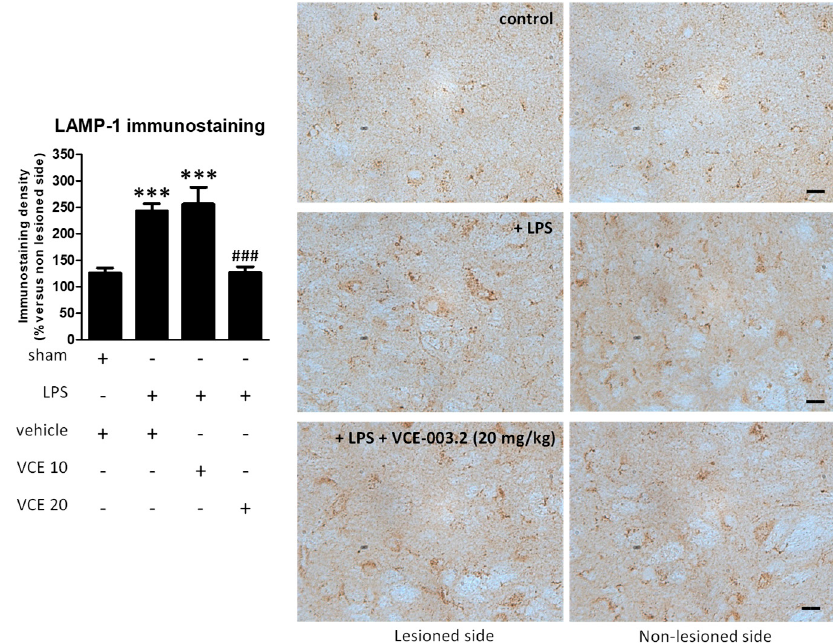
Figure 4. Intensity of the immunostaining for LAMP-1 measured in a selected area of the substantia nigra pars compacta of control and LPS-lesioned mice orally treated for 28 days after lesion with vehicle (corn oil) or VCE-003.2 at the doses of 10 (VCE 10) or 20 (VCE 20) mg/kg. Immunoreactivity values are measured in the lesioned side over the non-lesioned side, and correspond to means ± SEM of more than six subjects per group. Data were assessed using the one-way analysis of variance followed by the Bonferroni test (*** p < 0.005 versus vehicle-treated control (sham) mice; ### p < 0.005 versus vehicle-treated LPS-lesioned mice). Representative immunostaining images for sham and LPS-lesioned mice treated with vehicle or VCE-003.2 at 20 mg/kg are shown to the right (scale bar = 25 µm).